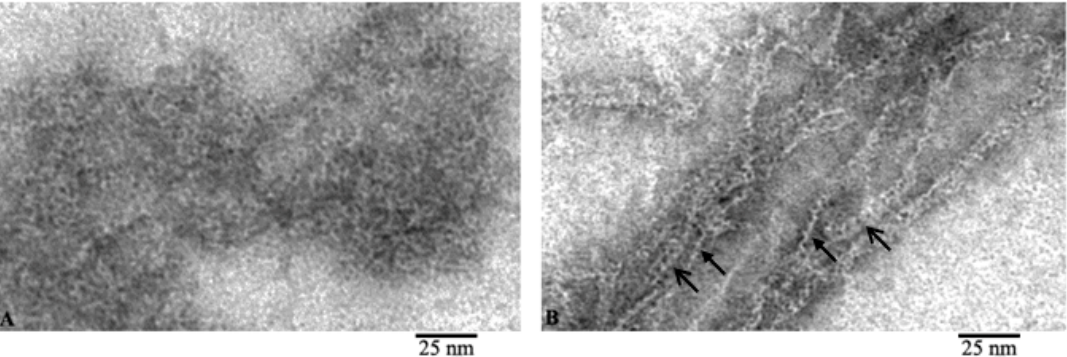
Figure 3. Comparison of G- and F-actin ( A and B , respectively). Filaments during adsorption on the film by the front (open arrow) and lateral (closed arrow) surfaces of actin molecules.